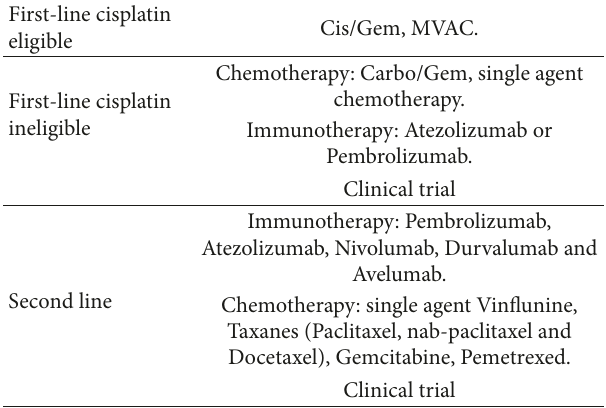
Table 1: Treatment options for metastatic urothelial carcinoma